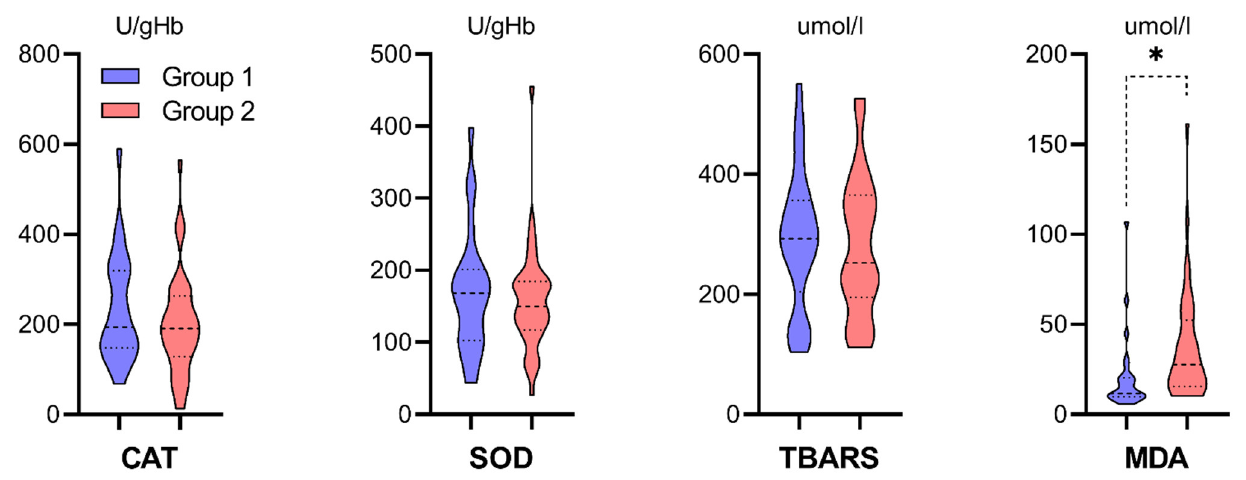
Figure 4. Violin plots of distribution (Mann-Whitney U test, N = 66, n 1 = 26, n 2 = 40): CAT activity ( p = 0.3713), SOD activity ( p = 0.7007), TBARS concentration ( p = 0.6158), MDA concentration (* p = 0.0004 ).